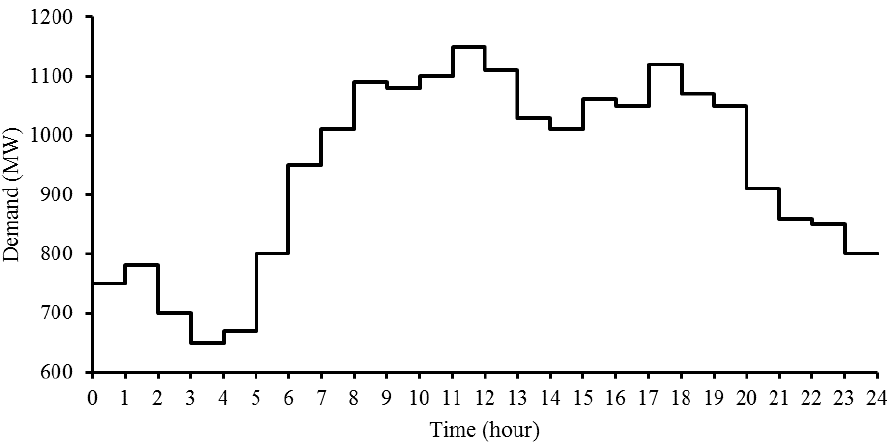
Figure 3. Load curve.